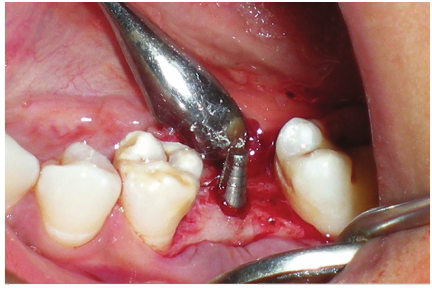
Figure 7: Implant placed into the osteotomy site.